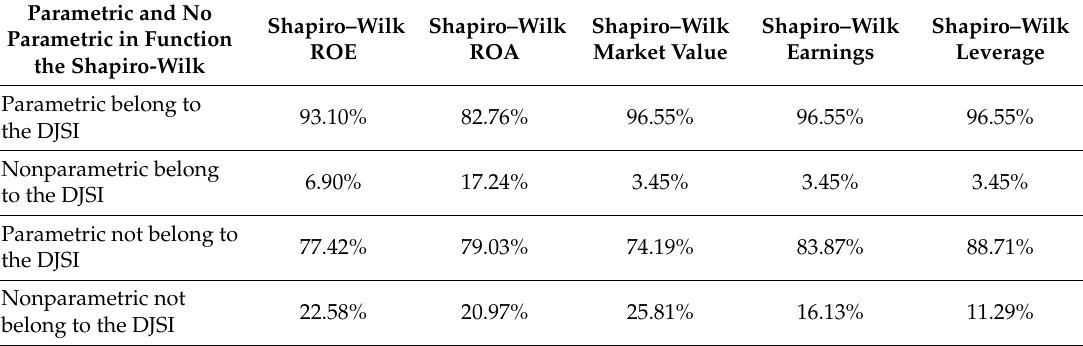
Table 1. Percentage normality tests according to the financial indices of the companies under study and that belong to the Dow Jones Sustainability Index (DJSI).